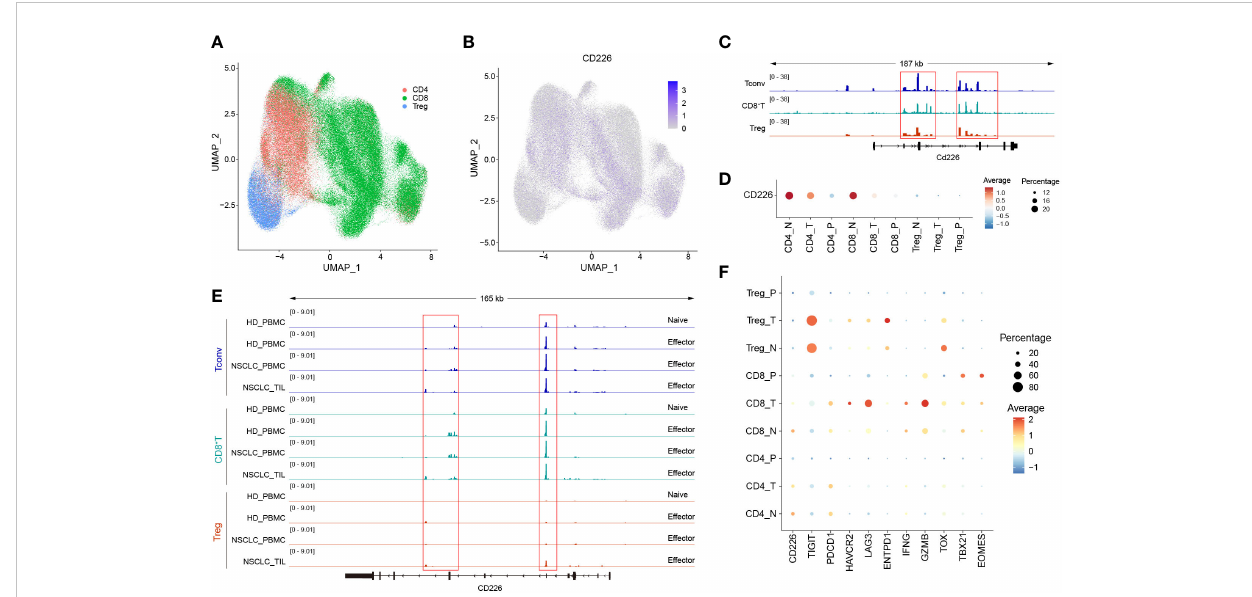
FIGURE 1 The expression of CD226 is up-regulated in effector CD4 + and CD8 + T cells. (A, B) scRNA-seq data downloaded from the GEO dataset (GSE156728), UMAP plots showed the distribution of CD4 + T cells, CD8 + T cells, and Tregs and CD226 expression. (C) Bulk ATAC-seq data for TILs in the MC38 model downloaded from the GEO dataset (GSE211155), genome tracks of bulk ATAC-seq data in the Cd226 locus, grouped by different clusters. (D) Dot plot showed the expression of CD226 in different sub-types of T cells from various tissues. (E) Genome tracks of bulk ATAC-seq data in CD226 locus, grouped by different samples. Bulk ATAC-seq data of T cells for healthy donors and non-small cell lung cancer were downloaded from the GEO dataset (GSE211155). (F) Dot plot showed the expressions of selected genes in different types of T cells from various